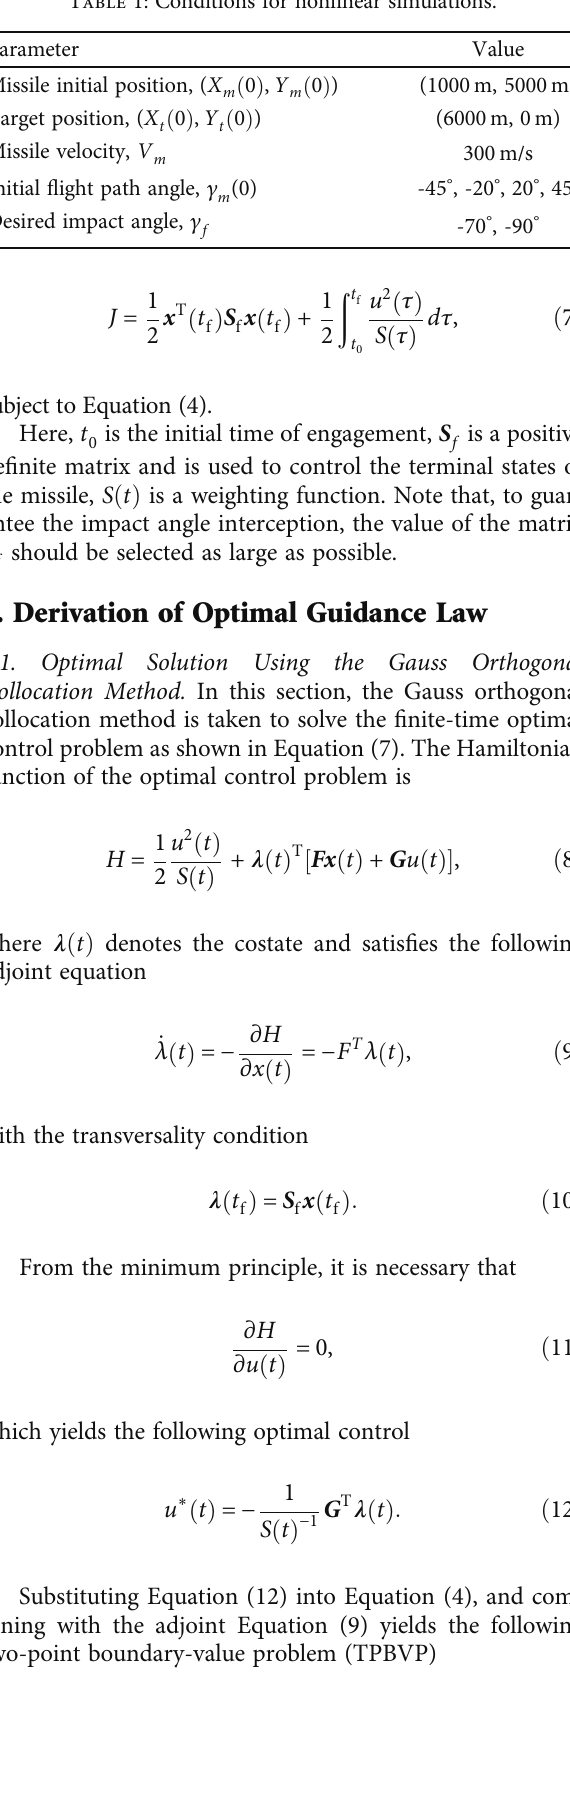
Table 1: Conditions for nonlinear